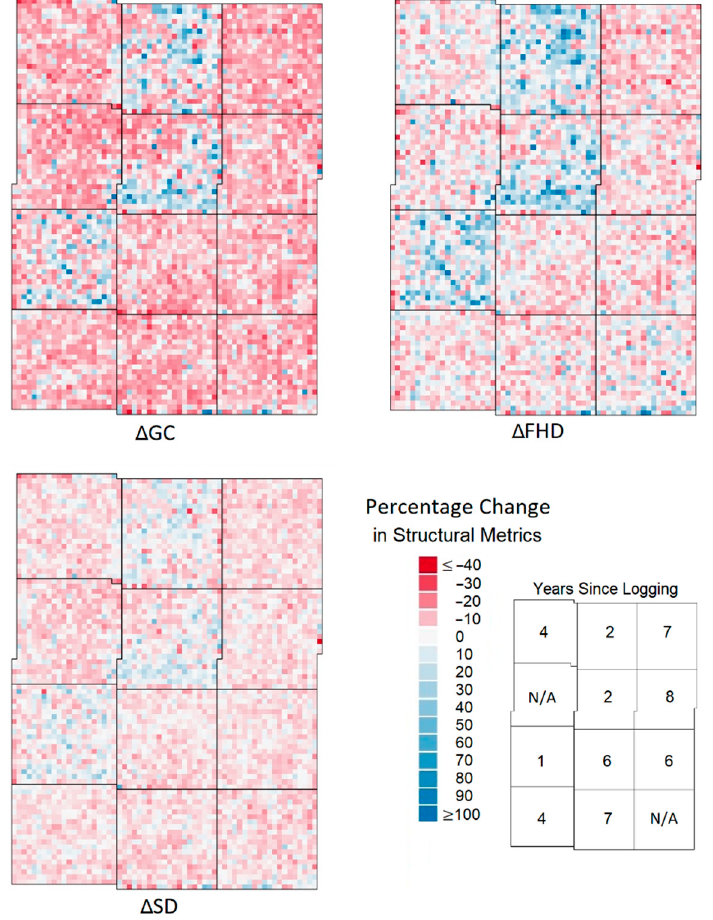
Figure 6. Maps of the percentage change in structural complexity metrics across the study area between 2012 and 2014 (resolution 50 m). Change is depicted by colour gradient with red representing the greatest negative change and blue the greatest positive change. Δ GC—change in Gini coefficient, Δ FHD—change in foliage height diversity, Δ SD—change in standard deviation of heights.